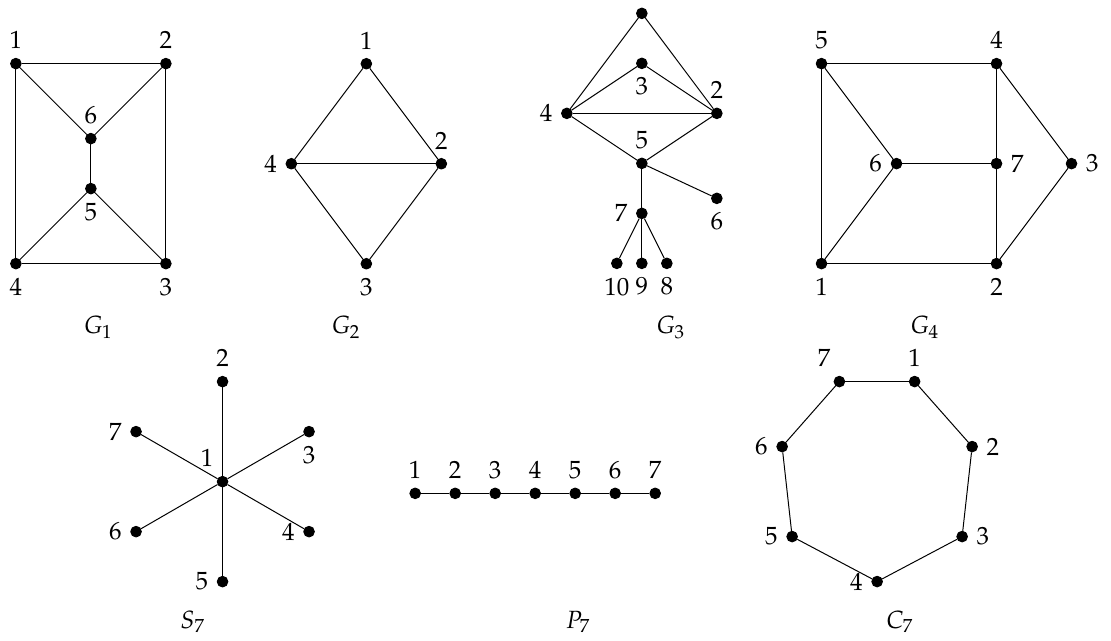
Figure 1. Examples of seven connected simple undirected